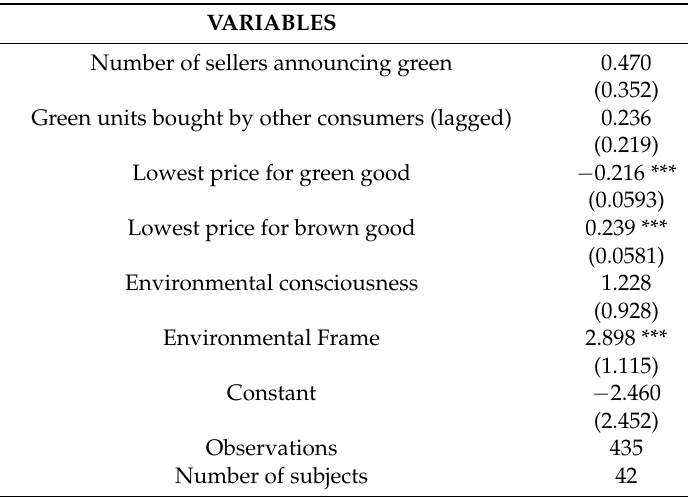
Table 8. Panel data Logit model for the probability of buying